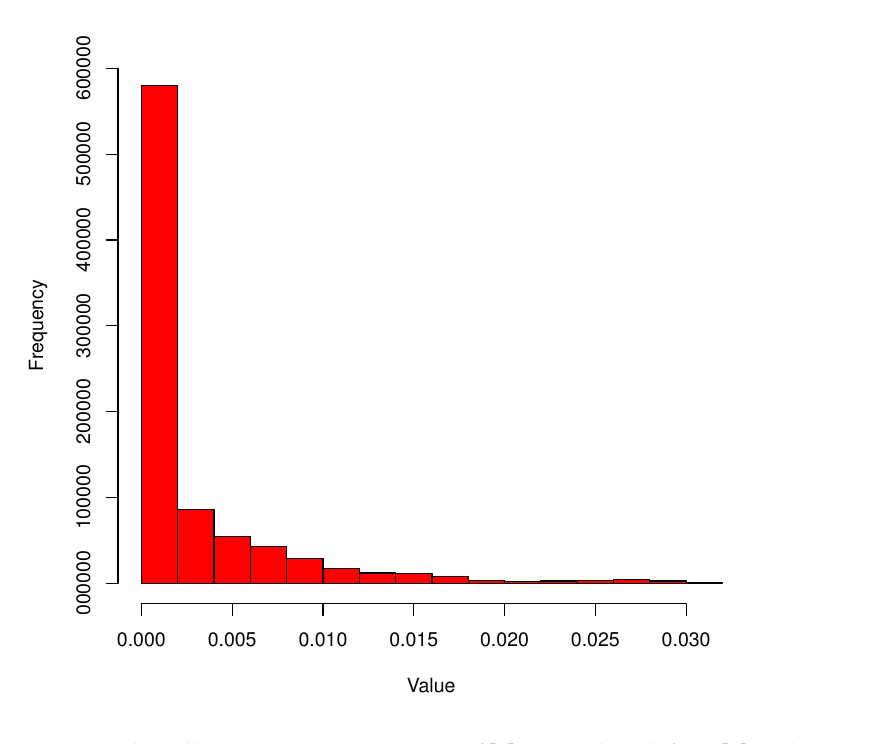
Figure 7. Precision and recall rates on our reproduction of [2], original work from [2], and tests using the images obtained with the TLR device prototype,